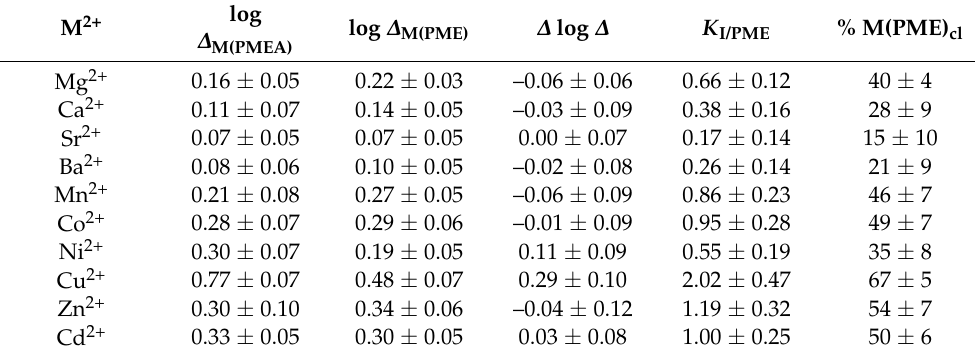
Table 2. Stability enhancements (Equation (12)) for the M(PMEA) and M(PME) complexes and their comparison according to Equation (13). In addition, the extent of chelate formation according to Equilibrium (5) is given as expressed by the dimension-less equilibrium constant K I (Equations (6) and (10)) and the percentages of M(PME) cl (Equation (14)). (Aqueous solution; 25 ◦ C; I = 0.1 M, NaNO 3 ) a,b